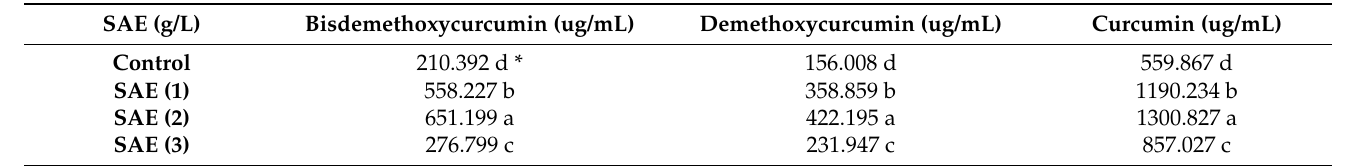
Table 10. Effects of Spirulina platensis aqueous extract (SAE) treatment on bisdemethoxycurcumin, demethoxycurcumin and curcumin (ug/mL) accumulation of C. longa .